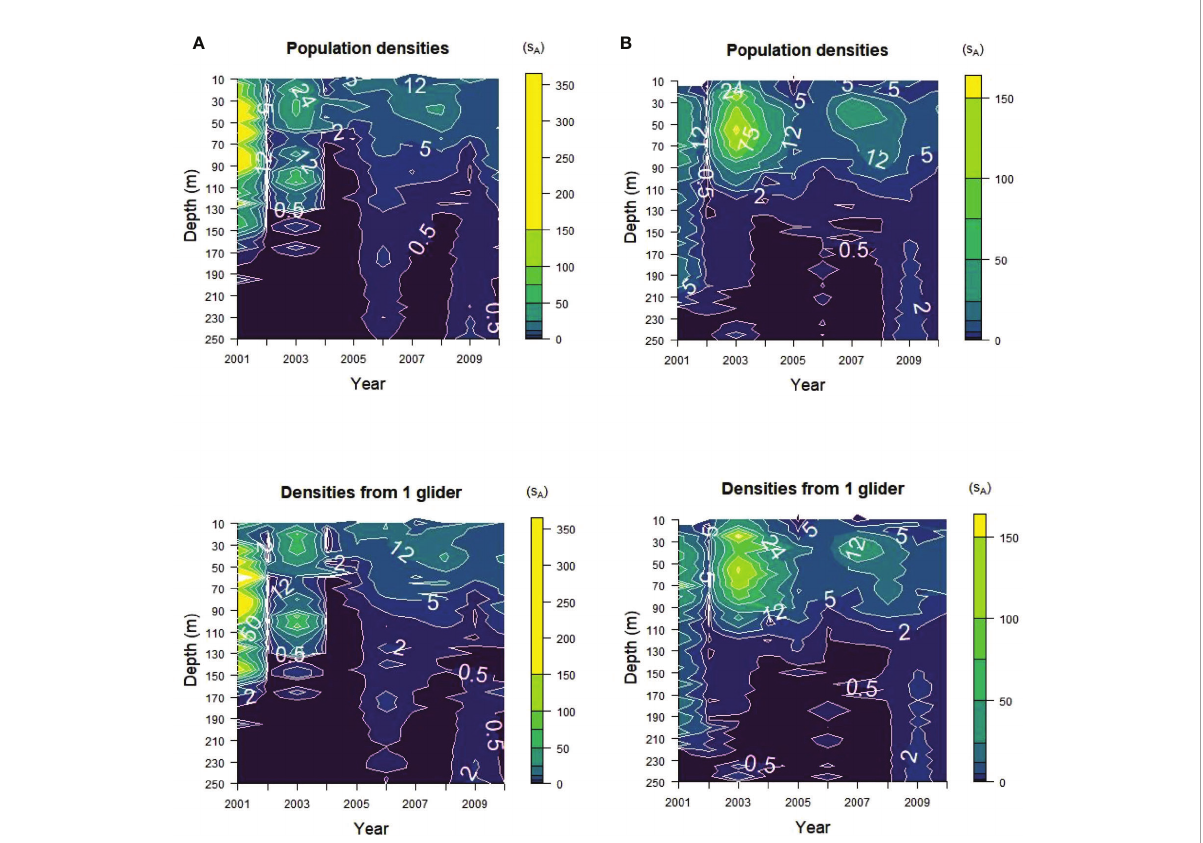
FIGURE 6 Acoustic energy contours with depth from (A) Brans fi eld Strait and (B) Cape Shirreff. The true energies ( “ Population densities ” ) and one randomly selected glider replicate with maximum dives of 150 m ( “ Densities from 1 glider ” ) are shown. Note the scale differences between the two strata, with higher maximum densities for Brans fi eld Strait than for Cape